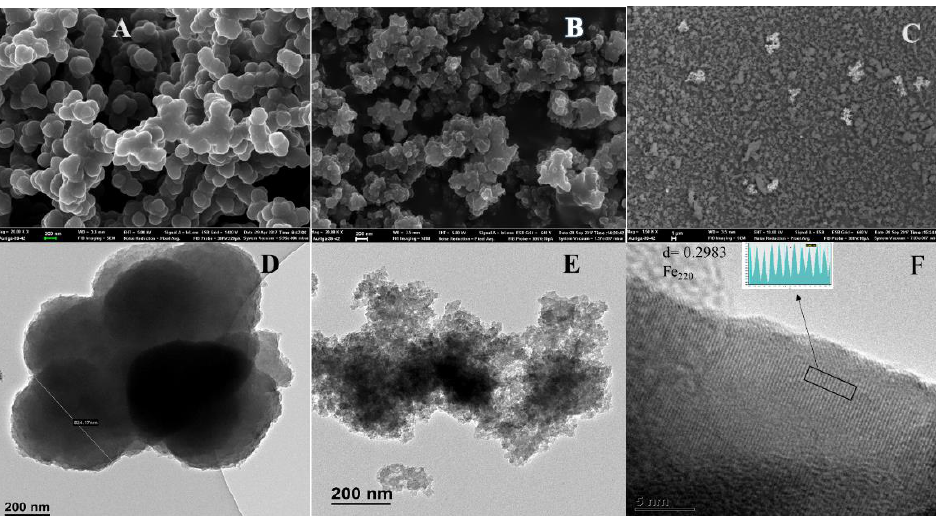
Figure 1. Scanning electron microscopy (SEM) images of polypyrrole (PPy) ( A ) and polypyrrole- m -phenylediamine/Fe 3 O 4 (PPy– m PD/Fe 3 O 4 ) nanocomposite ( B,C ); Transmission electron microscopy (TEM) images of PPy ( D) and PPy– m PD/Fe 3 O 4 nanocomposite ( E ); High resolution transmission electron microscopy (HR-TEM) of the PPy– m PD/Fe 3 O 4 nanocomposite ( F ). N.B: Field-emission scanning electron microscopy ( FE-SEM) image of the nanocomposite carried out in the backscattered mode (C) .